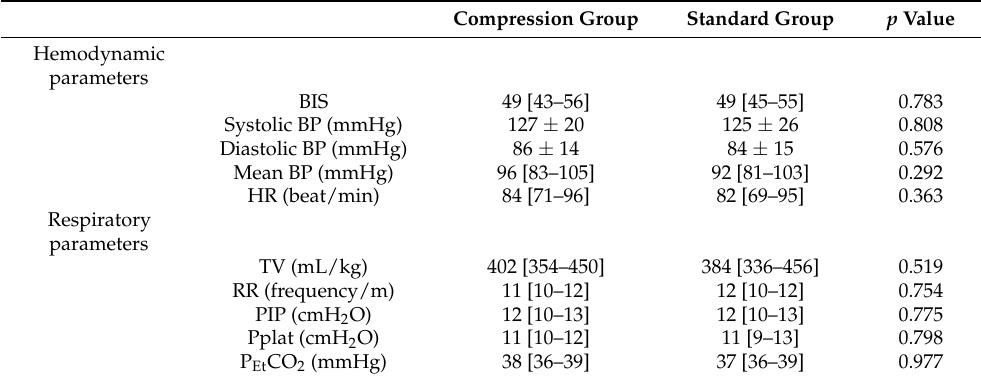
Table 2. Hemodynamic and respiratory parameters at ultrasound-guided radial artery catheteriza-